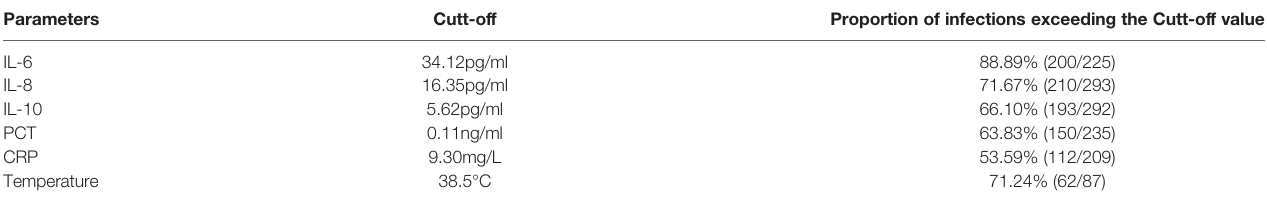
TABLE 3 | Cut-off value of IL-6, IL-8, IL-10, PCT, CRP and temperature. Parameters Cutt-off Proportion of infections exceeding the Cutt-off